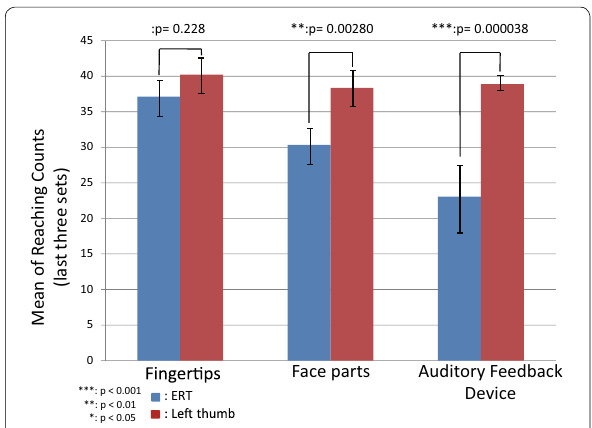
Fig. 10 The mean values of all the subjects in the last three sets. The successful reaching counts by ERT and the reaching counts by subjects’ own left thumb in the last three experimental sets are compared